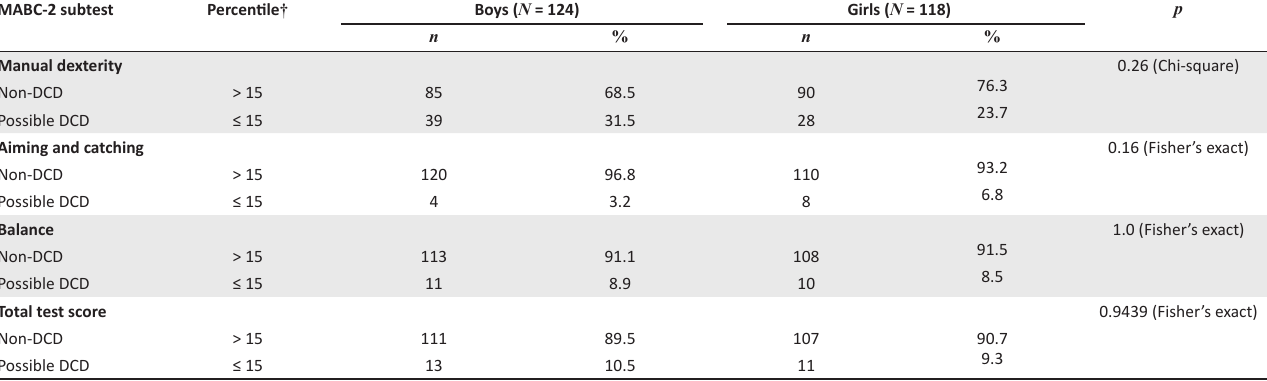
TABLE 5: Differences between boys and girls on the Movement Assessment Battery for Children-2nd edition total test score and subtests. MABC-2 subtest